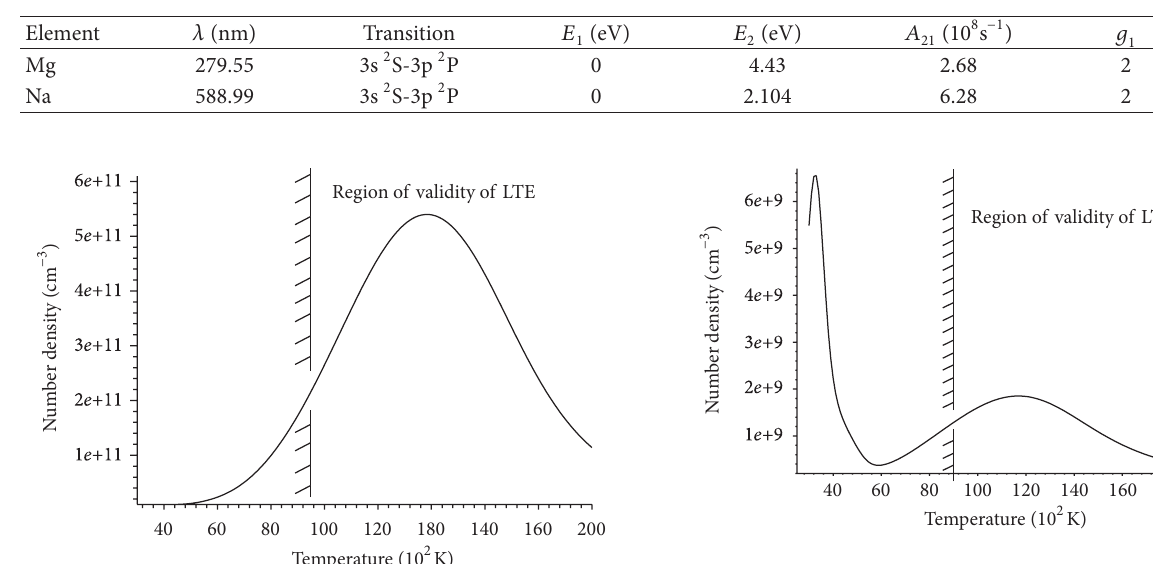
-NaCl solution 2